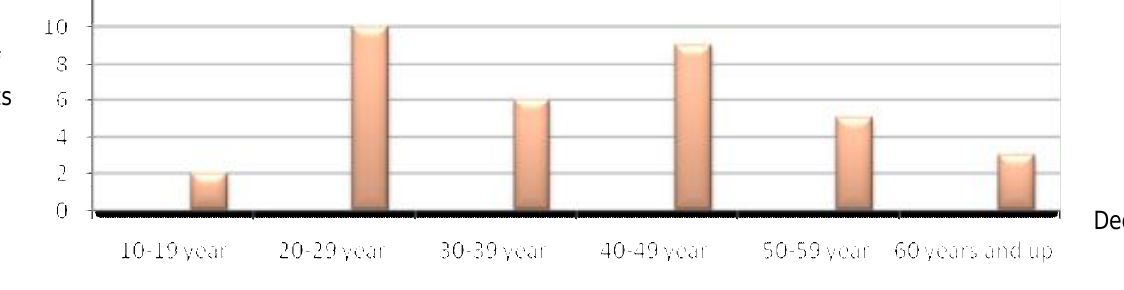
Figure (2): Benign group age